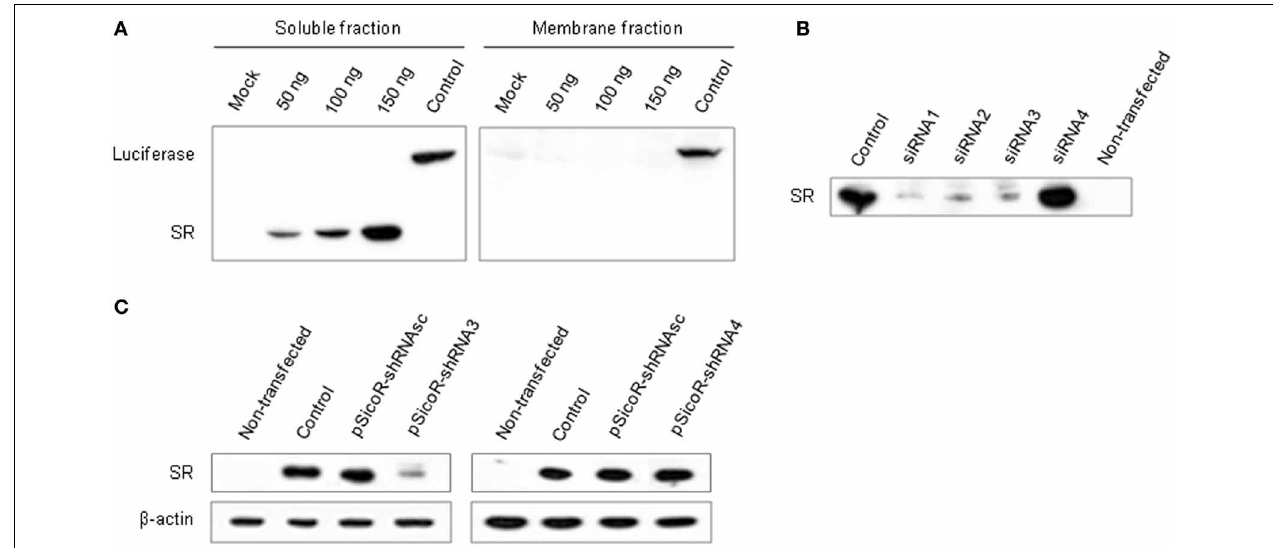
FIGURE 1 | Establishment of siRNA-dependent knockdown of a target gene (SR) in vitro . (A) Western blot showing luciferase and SR expression in Hek293T cells transfected with 50, 100, and 150 ng of pCMV-Tag2-SR encoding SR fused to an epitope peptide (flag). Mock, empty pCMV-Tag2 plasmid; Control, pCMV-Tag2 plasmid carrying a tagged firefly luciferase. Optimal cell delivery was determined by comparing siRNA-Alexa 488 fluorescence distribution (not shown). (B) Silencing efficiency of SR siRNAs. Western blot showing SR